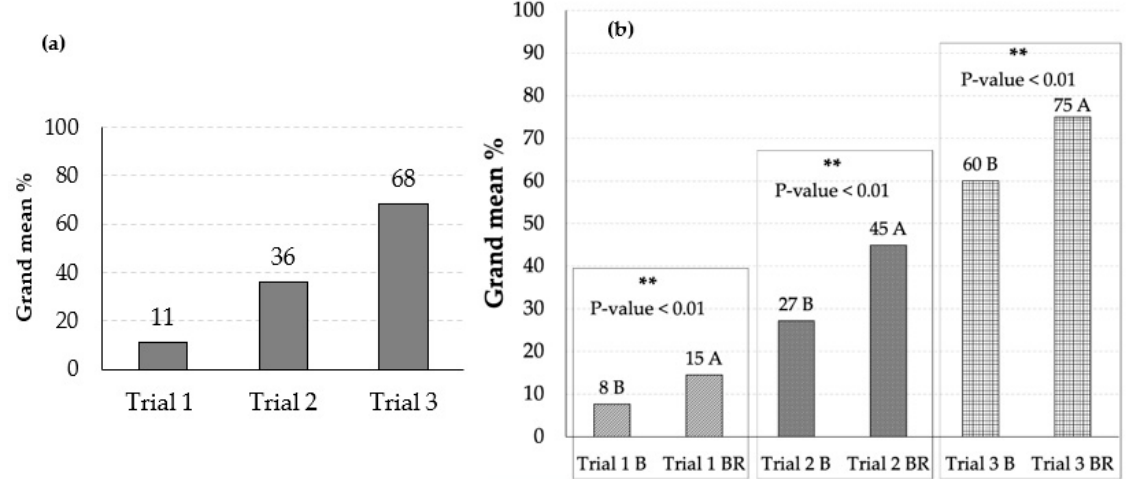
Figure 8. ( a ) The grand mean seedling emergence % (average of all 12 treatments for each trial). ( b ) The mean for each planting method for each trial (average for 6 coating treatments), B = broadcasting and BR = broadcasting and raking, different letters indicate significant differences (** p < 0.01). Table 2. Percent plant stand count of six different treatments of two planting methods (B and BR) at three planting dates in the field (B = broadcasting and BR= broadcasting and raking).